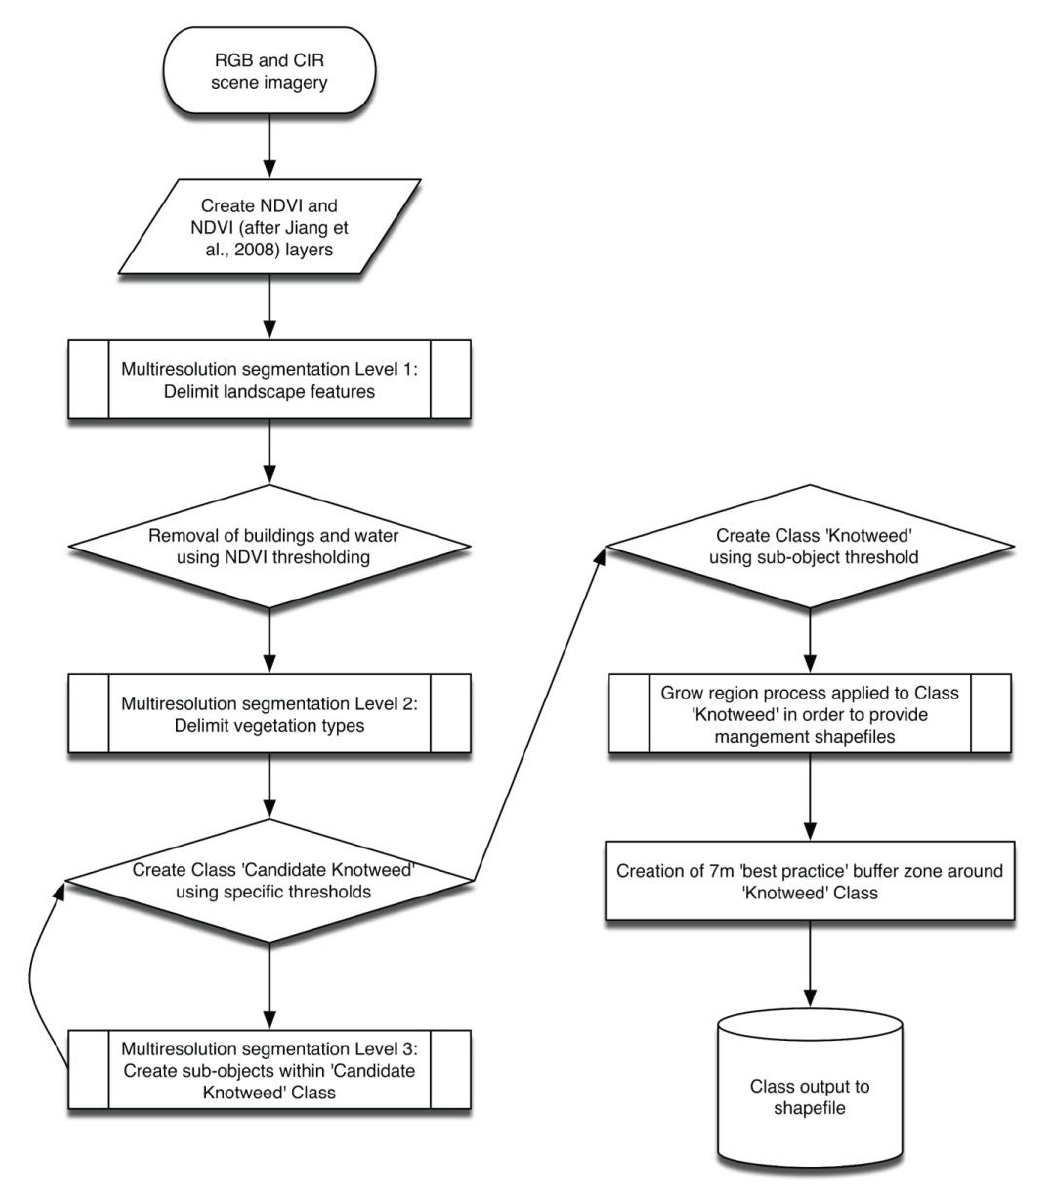
Figure 3. Data processing and through-flow chart for the current